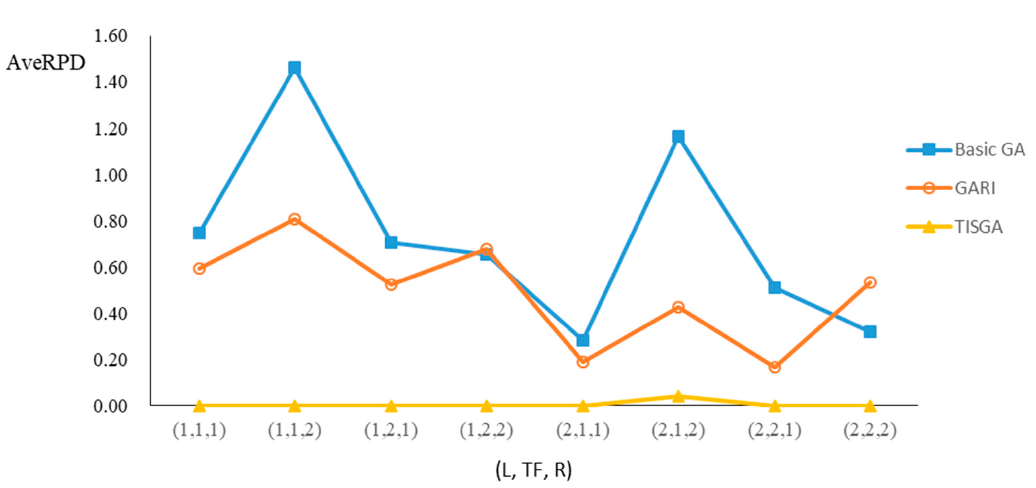
Figure 9. Comparison results for n = 25 with eight combinations of (L, TF, R).